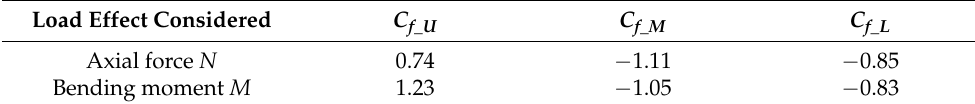
Table 2. Proposed wind force coefficients for the amin wind force resisting systems.